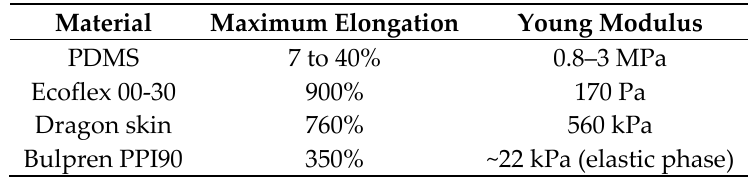
Table 1. Mechanical properties of different hyper-elastic materials used for microfluidics applications compared to conventional PDMS.